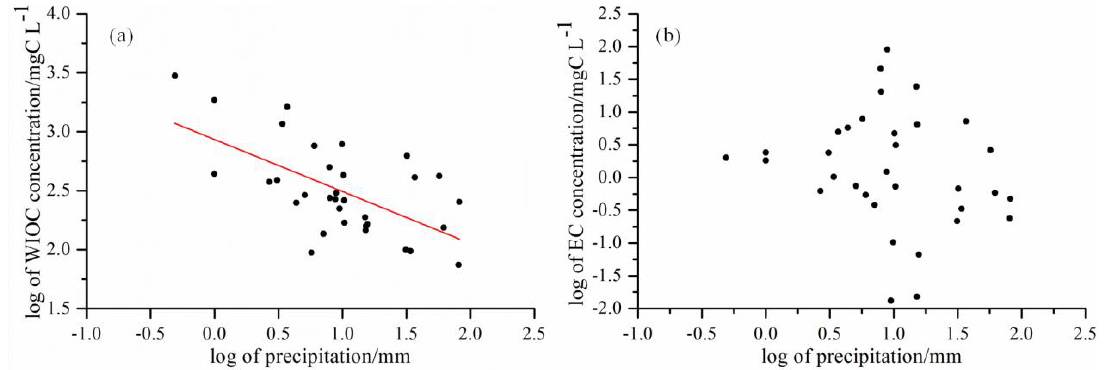
Figure 5. Relationships between the carbonaceous particle concentration in the rainwater and the precipitation amount of: ( a ) WIOC; and ( b ) EC.